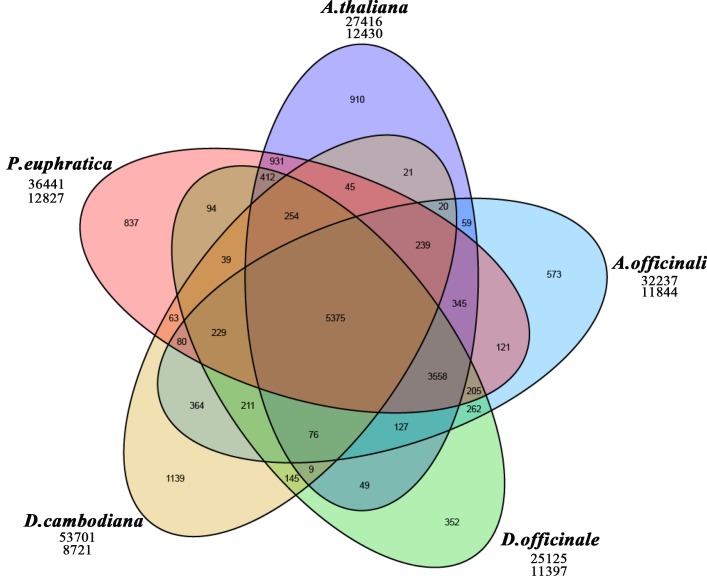
The number of gene clusters in D. cambodiana and other species.The first number under the plant species name is the total number of putative genes used for clustering. The second number under the plant species name is the number of clusters or families.